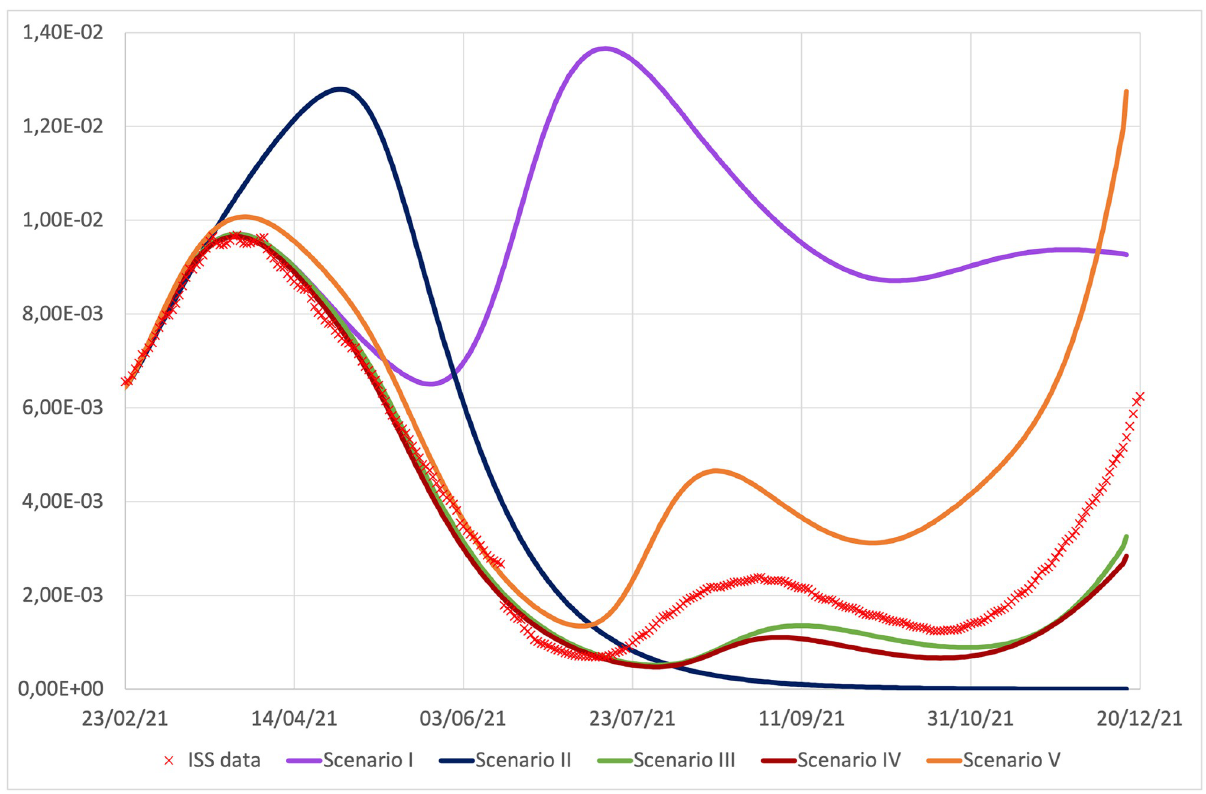
Fig 6. Diagnosed cases, I D , obtained turning off the seasonal term in Eq (8) (Scenario I, violet line), the awareness term in Eq (4) (Scenario II, blue line), the Delta variant term in Eqs (9) and (11) (Scenario III, green line), the mobility term in Eq (7) (Scenario IV, brown line), and the vaccinations (Scenario V, orange line), compared with the ISS data.